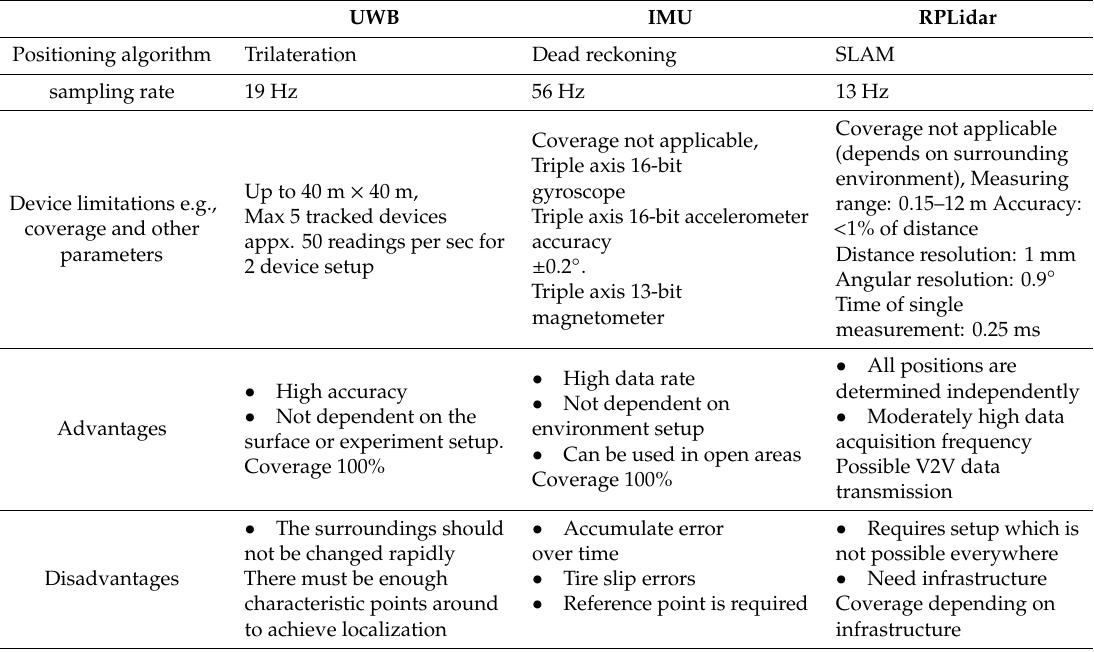
Table 1. Advantages, disadvantages and parameters related to devices used in the RC platform and related